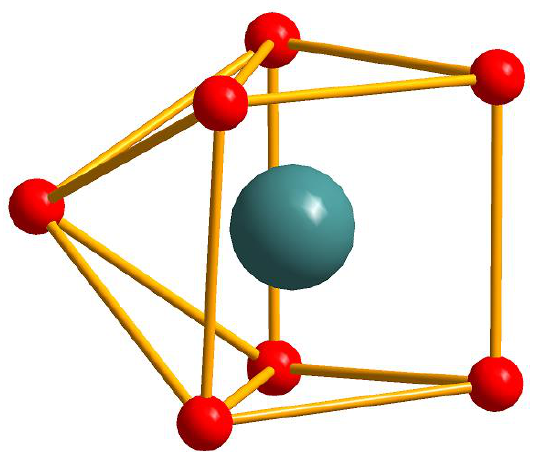
Figure 4. The distorted Capped Trigonal Prismatic coordination geometry of the Gd(III) ion in 8 with the GdO 7 sphere.